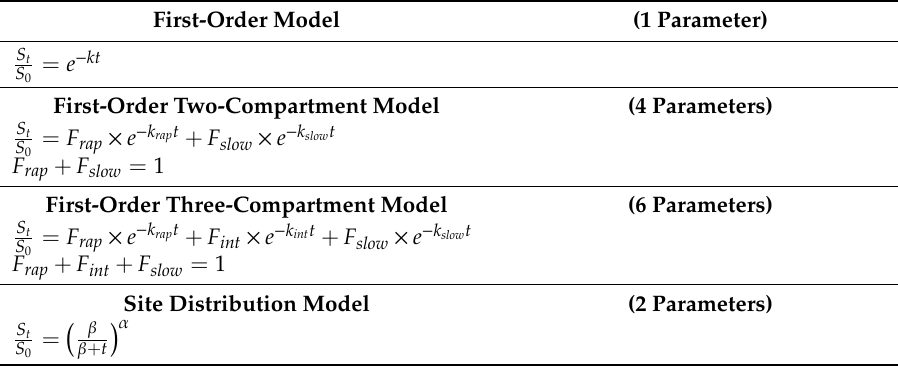
Table 2. Desorption models tested to describe the measured desorption kinetics of PAHs in the experimental soil. Models were adjusted using the Levenberg–Marquardt algorithm